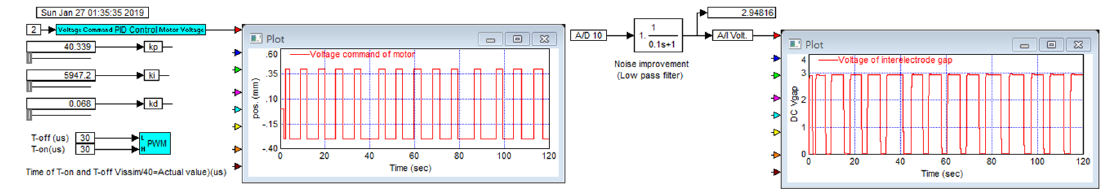
Figure 6. PID-M9 controller motor voltage command and interelectrode gap (IEG) voltage signal in colloid production.